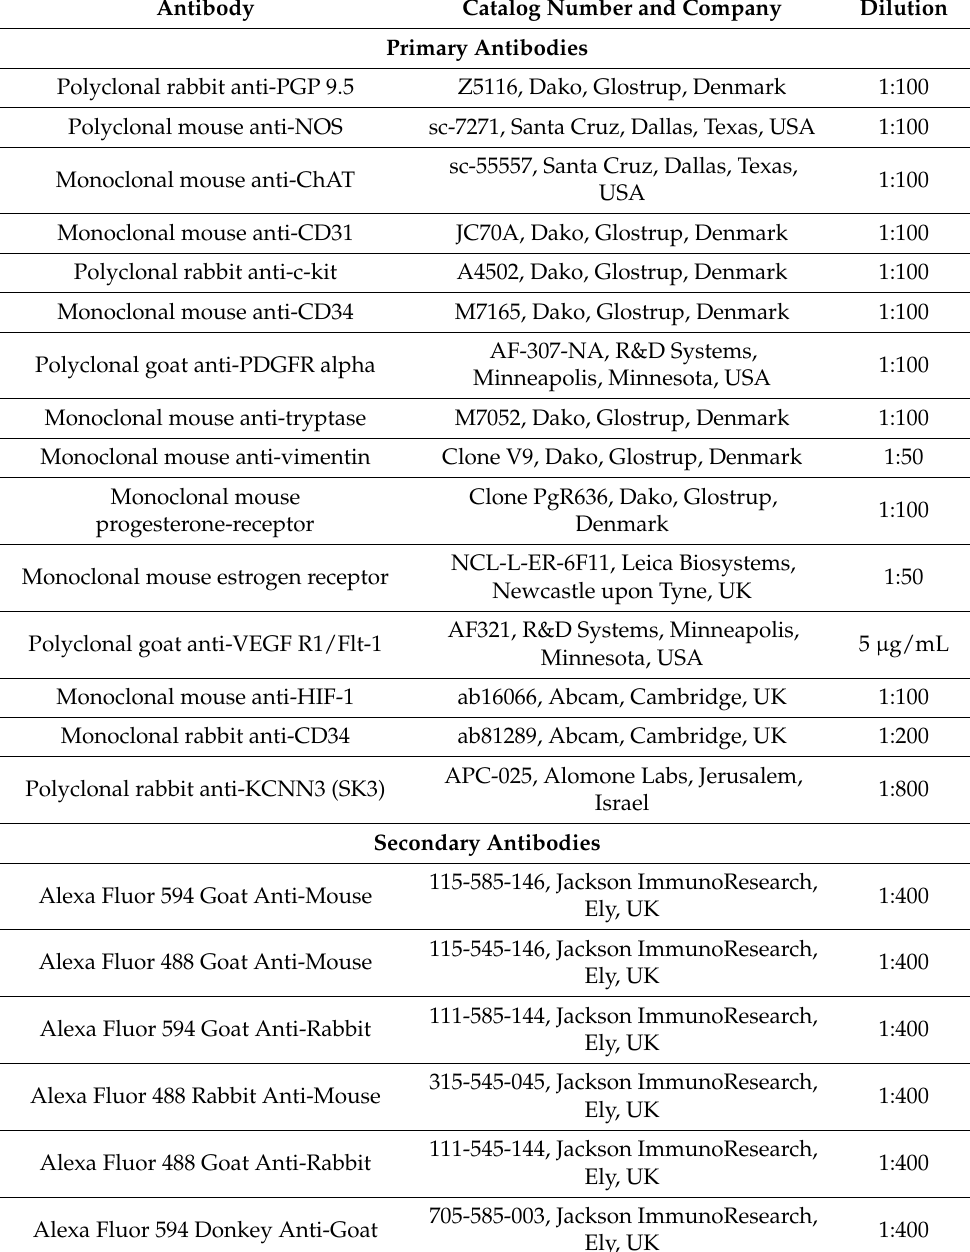
Table 2. Type, sources, and dilution of